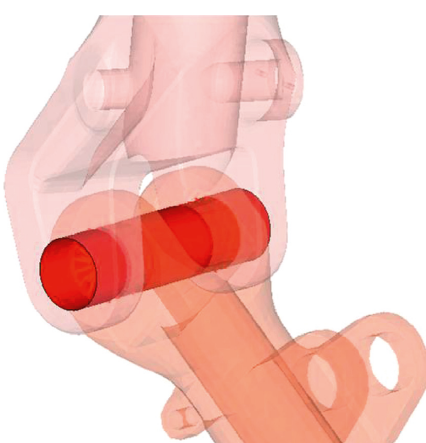
Figure 13: Pin linking the main fitting and the trailing arm.